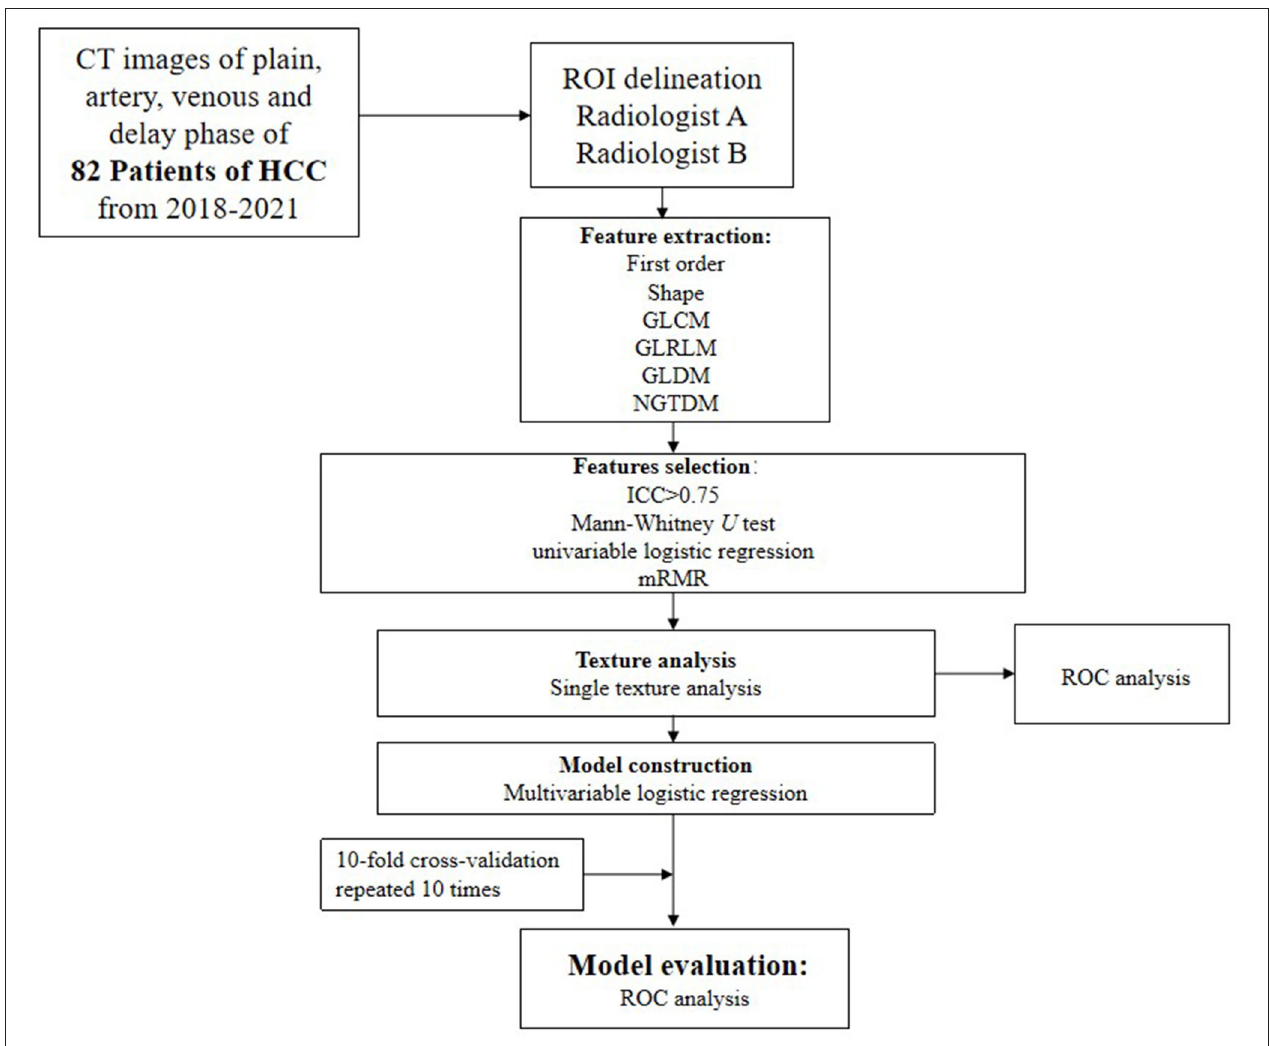
FIGURE 4 | Flowchart of feature selection, texture analysis, and model